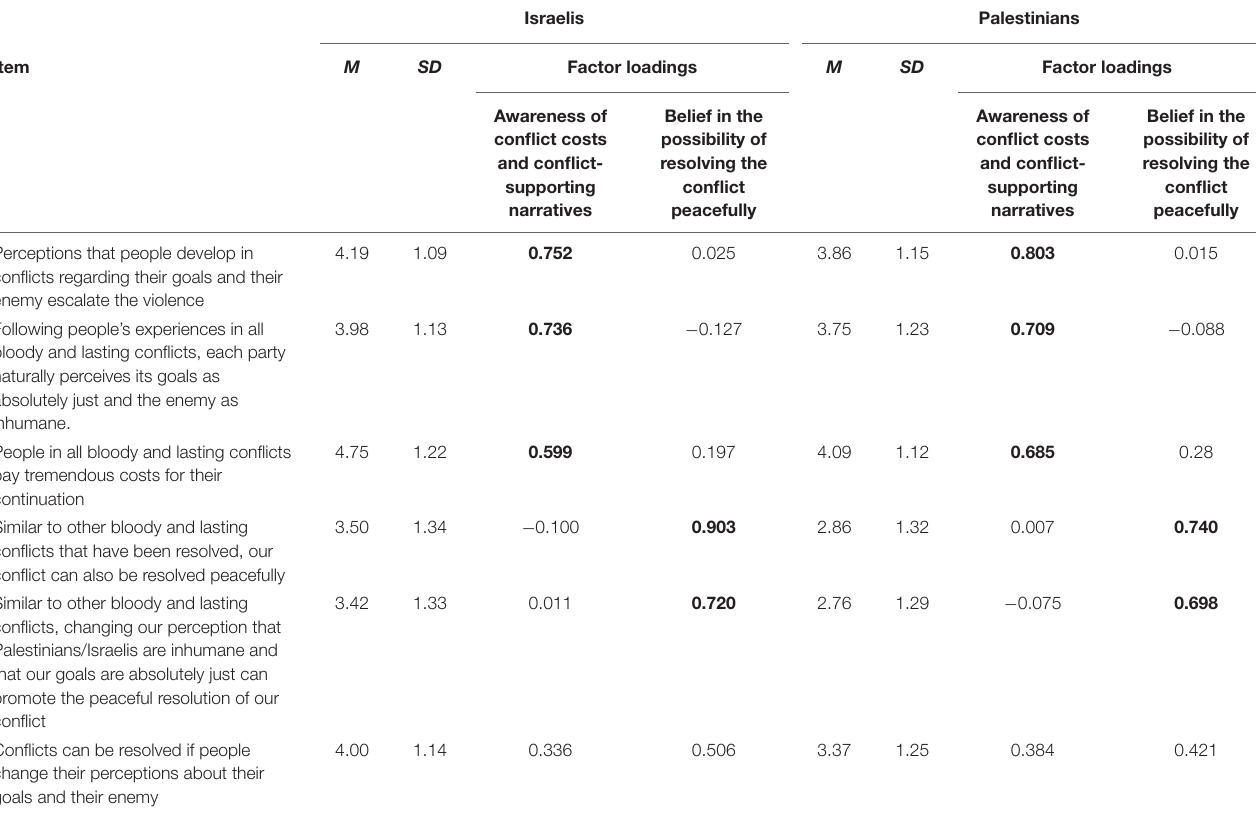
TABLE 1 | Means, SDs and factor loadings of items referring to awareness of conflict costs and conflict-supporting narratives and belief in the possibility of resolving the Israeli-Palestinian conflict peacefully among Israelis and Palestinians (Study 1).